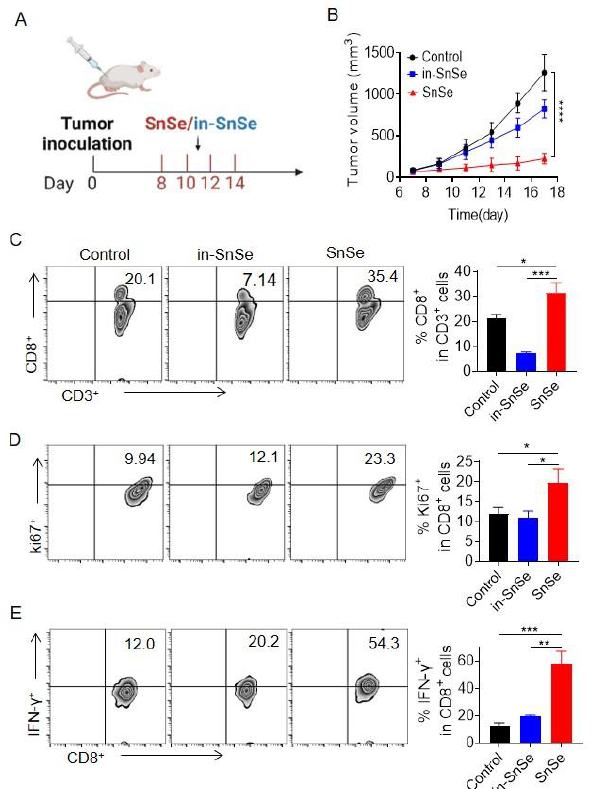
Figure 3. Evaluation of the antitumor efficacy of SnSe NSs. ( A ) The treatment scheme of SnSe NSs or in-SnSe NSs. ( B ) The tumor growth curve in CT26 subcutaneous tumor mice with various treatments ( n = 5). ( C – E ) Representative flow cytometry zebra plots and statistical analyses of immune cells in mice with different treatments. ( C ) CD8 + T cells. ( D ) Proportion of Ki67 within CD8 + T cells. ( E ) Quantitative measurement of IFN- γ + within CD8 + T cells . Data are means ± SDs. Statistical significance was calculated using one-way ANOVA followed by Tukey’s post-test . p -value: * p < 0.05; ** p < 0.01; *** p < 0.001; **** p < 0.0001. a.u., arbitrary units.